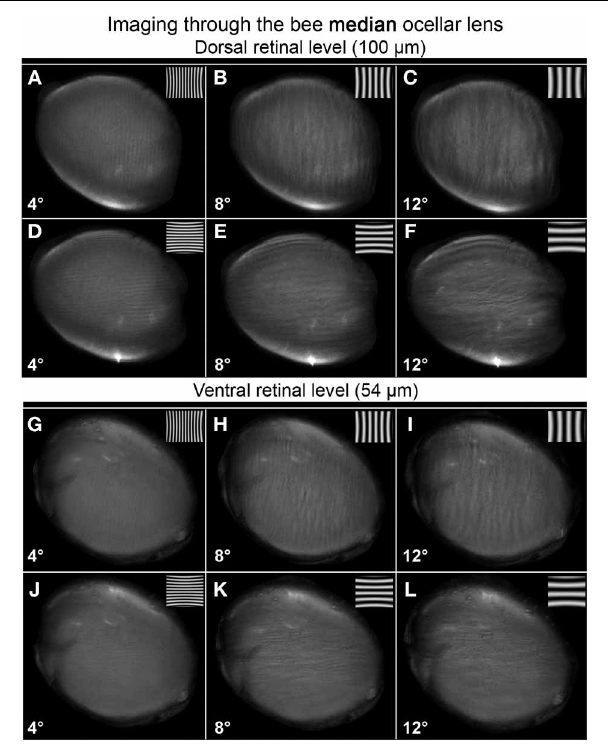
FIGURE 6 | Images of gratings through the honeybee lateral ocellus at the dorsal retinal level (A–F; 140 µ m away from the back of the lens) and ventral retinal level (G–L; 80 µ m away from the back of the lens). Spatial wavelength: ADGJ: 2 ◦ ; BEHK: 4 ◦ ; CFIL: 8 ◦